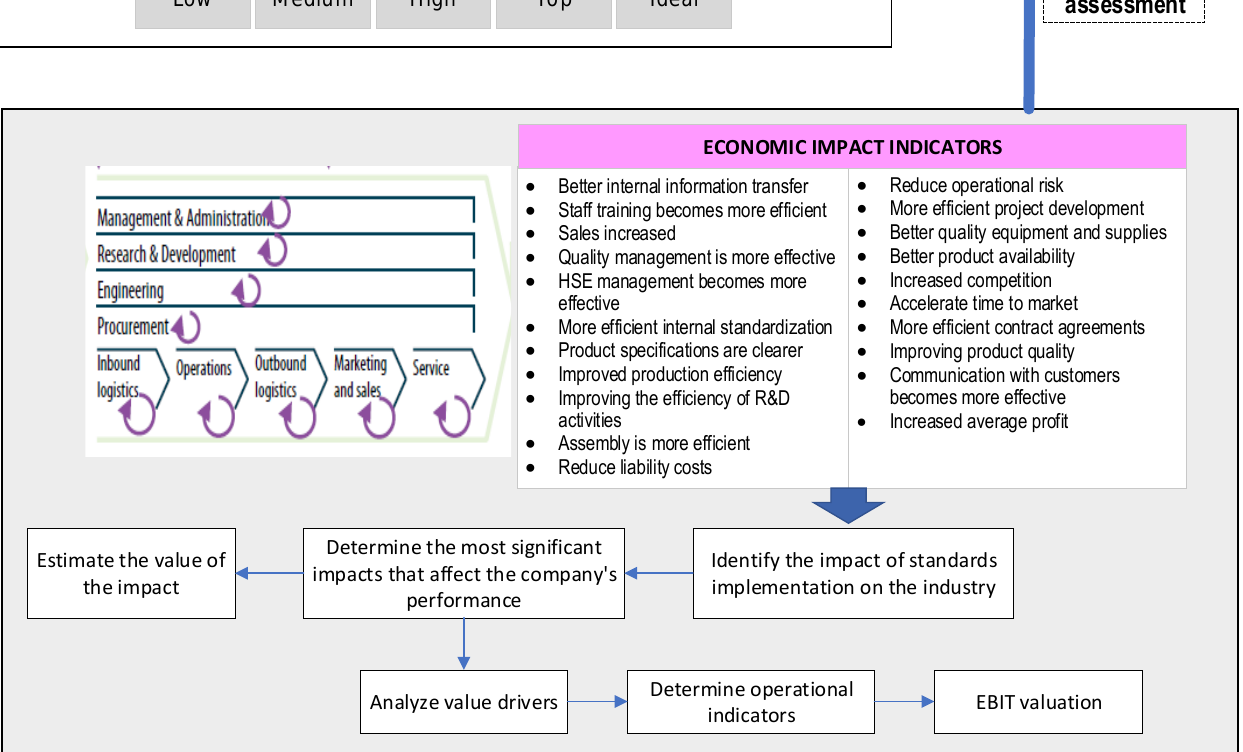
Figure 4. Model for measuring technology readiness and economic benefits of standard implemen- tation.